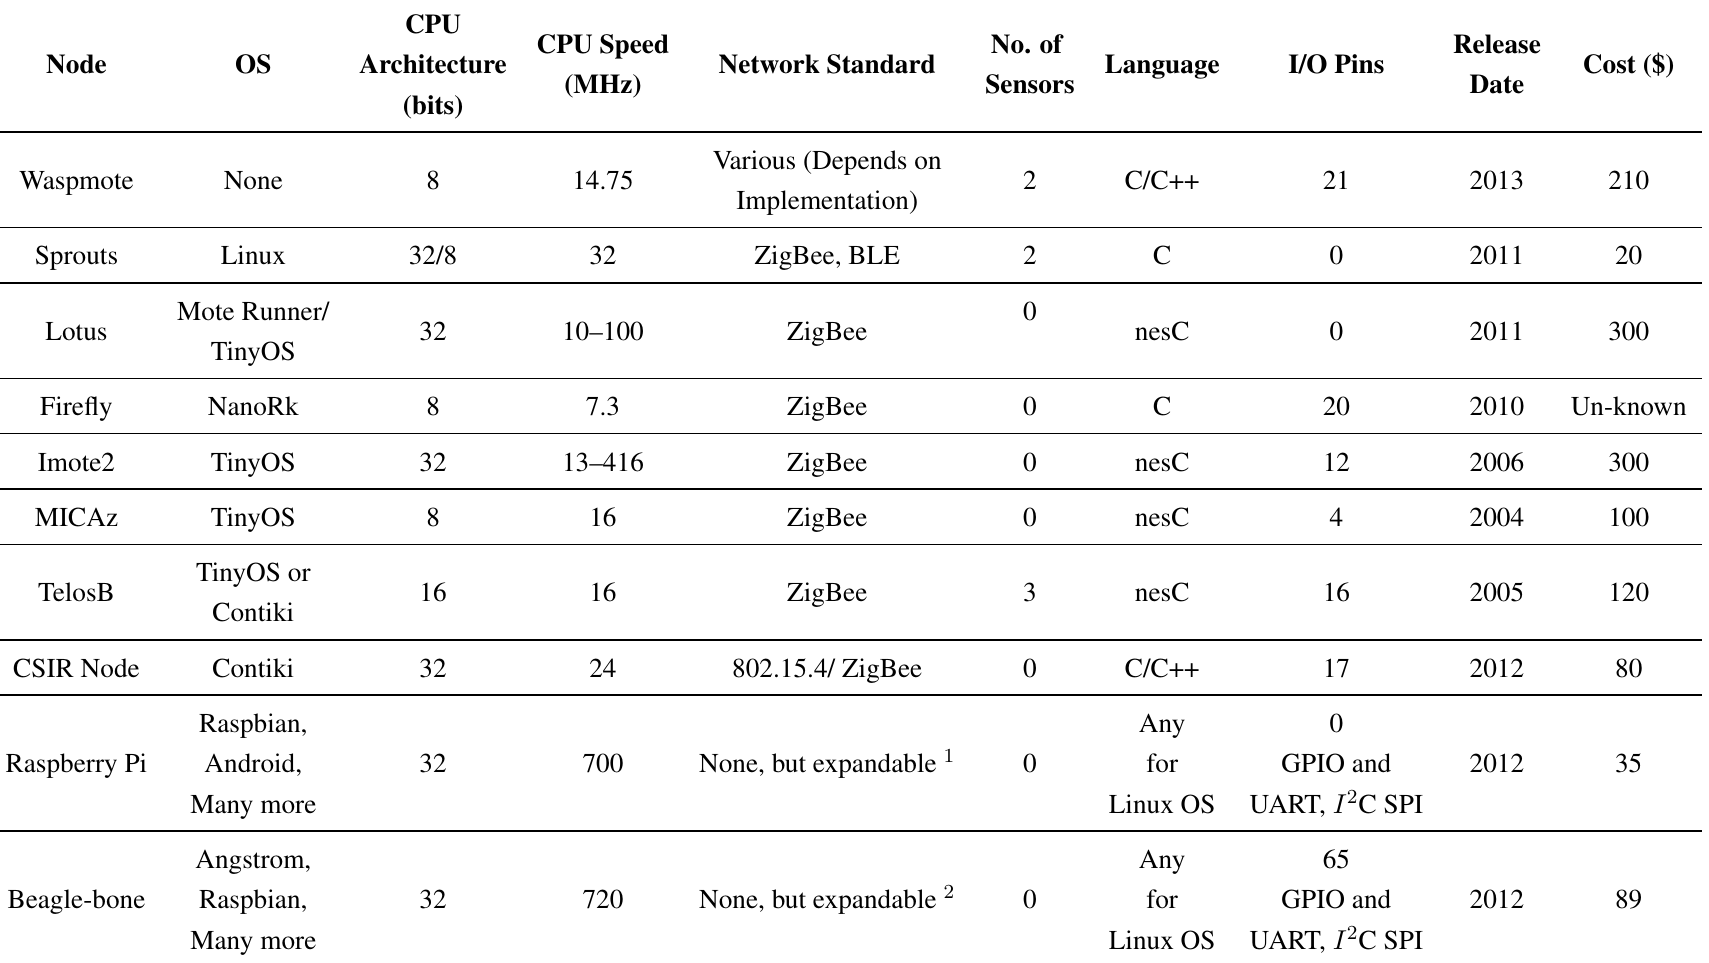
Table 1. Table showing features of the WSN nodes. GPIO, general purpose input